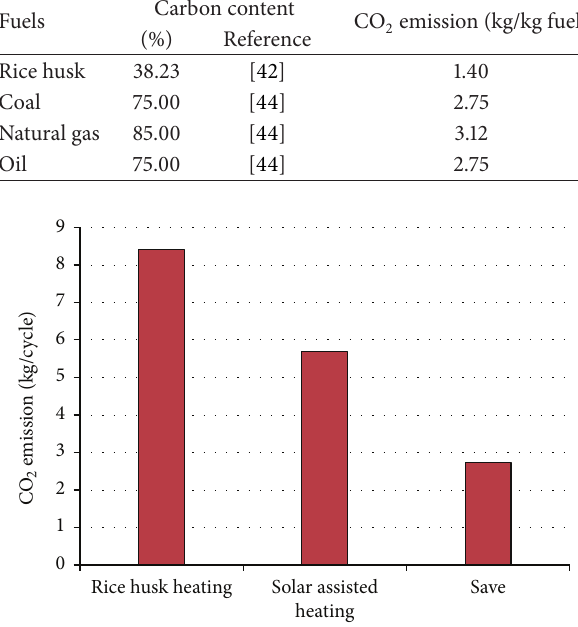
Figure 7: Emission from rice husk heating and solar assisted heating.